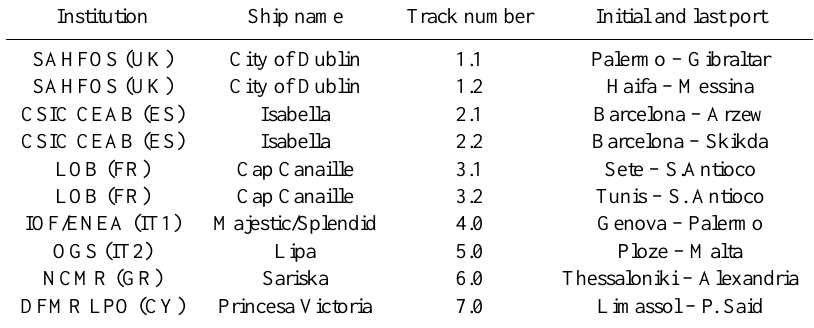
Table 1. Institutions, names of ships, track numbers and start/end ports of the initial monitoring design